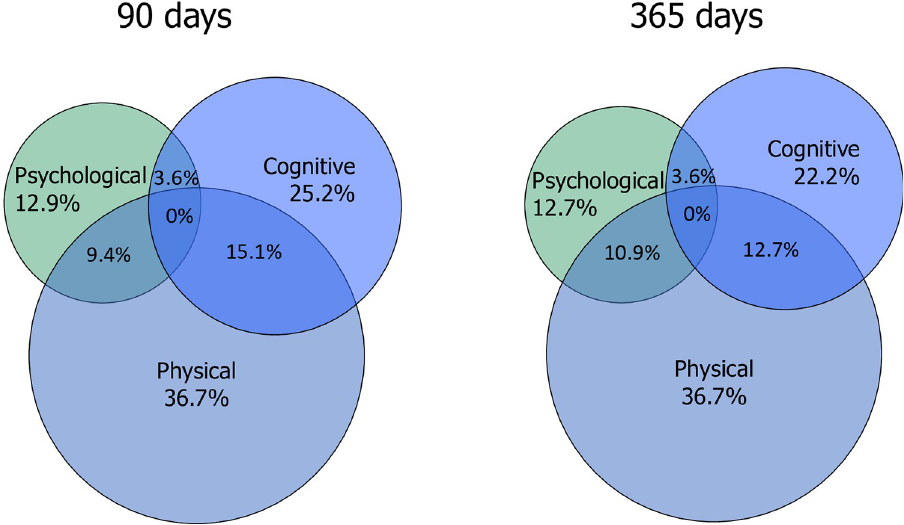
Fig 2. Co-occurrence of post-intensive care syndrome domains at 3 and 12 months. Note: Post-intensive care syndrome domains, i.e. physical, cognitive and psychological symptoms, and overlaps between the different domains.